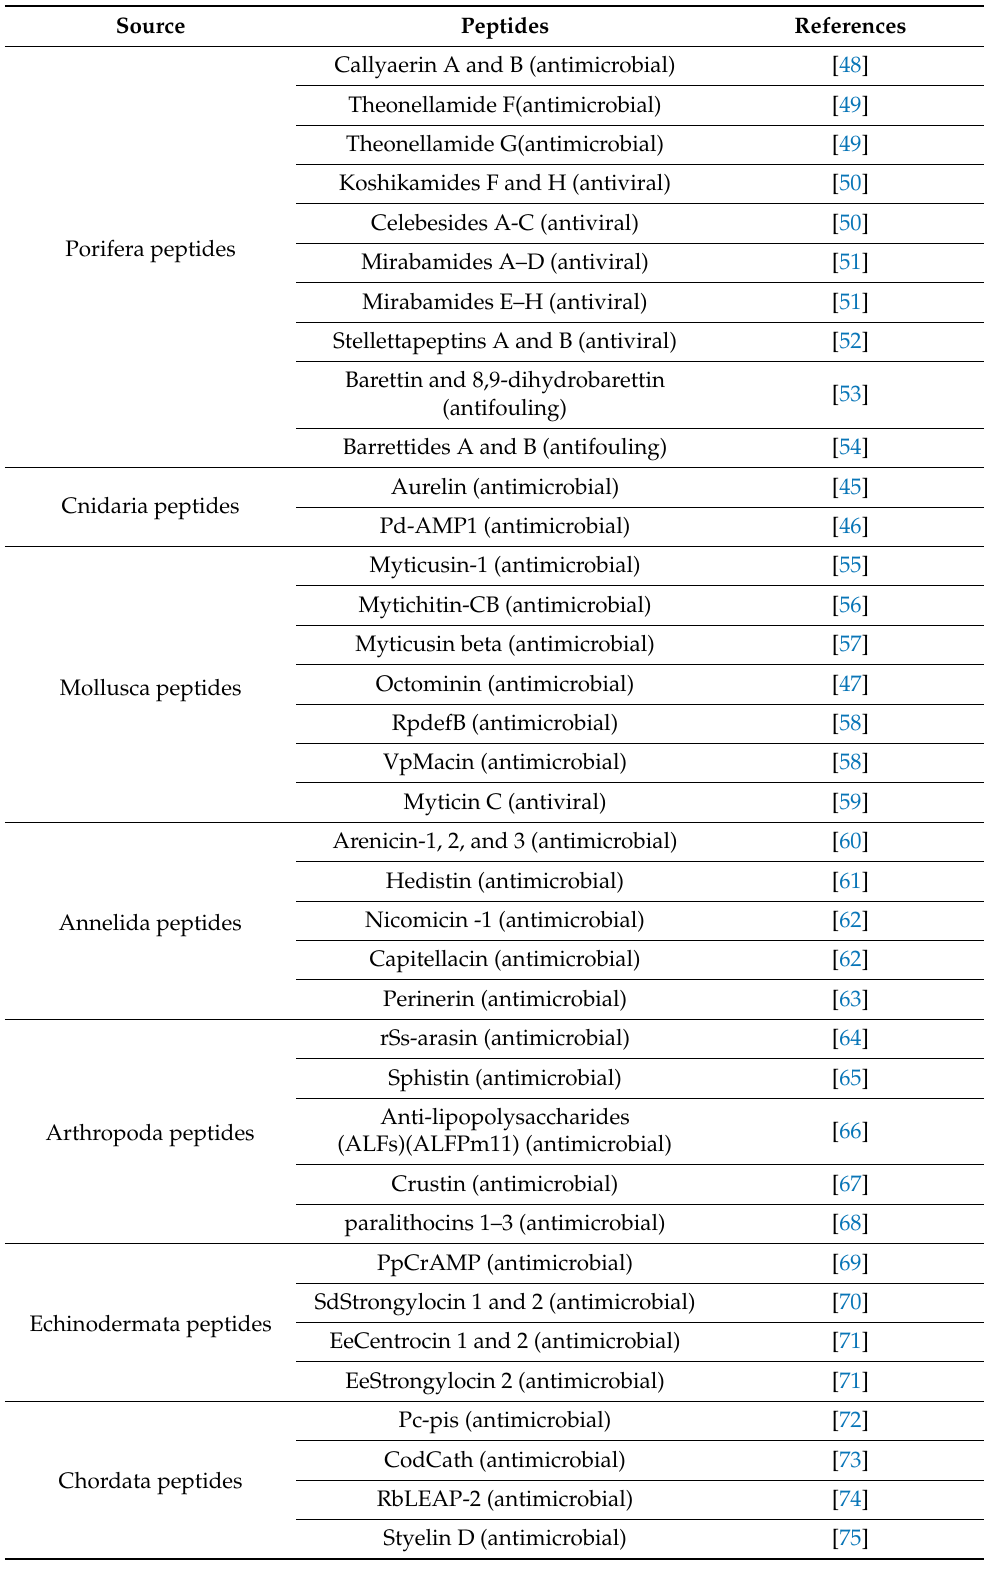
Table 2. Anti-microbial peptides isolated from marine